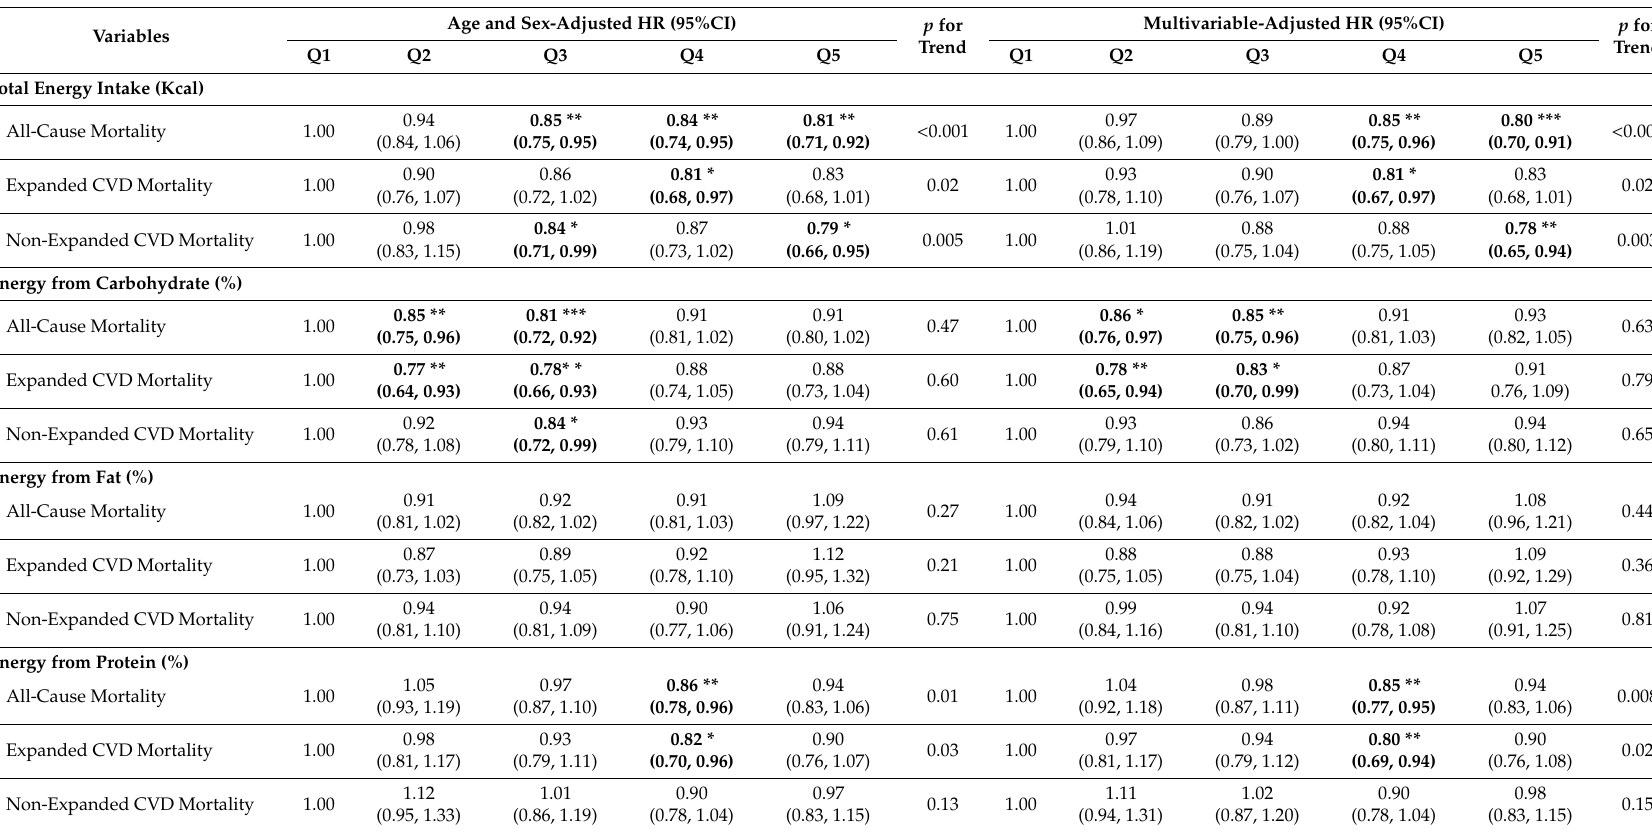
Table 2. The hazard ratios (HRs) of mortality, according to quintile of dietary intake in diabetic patients enrolled in Diabetes Care Management Program of a medical center ( n =